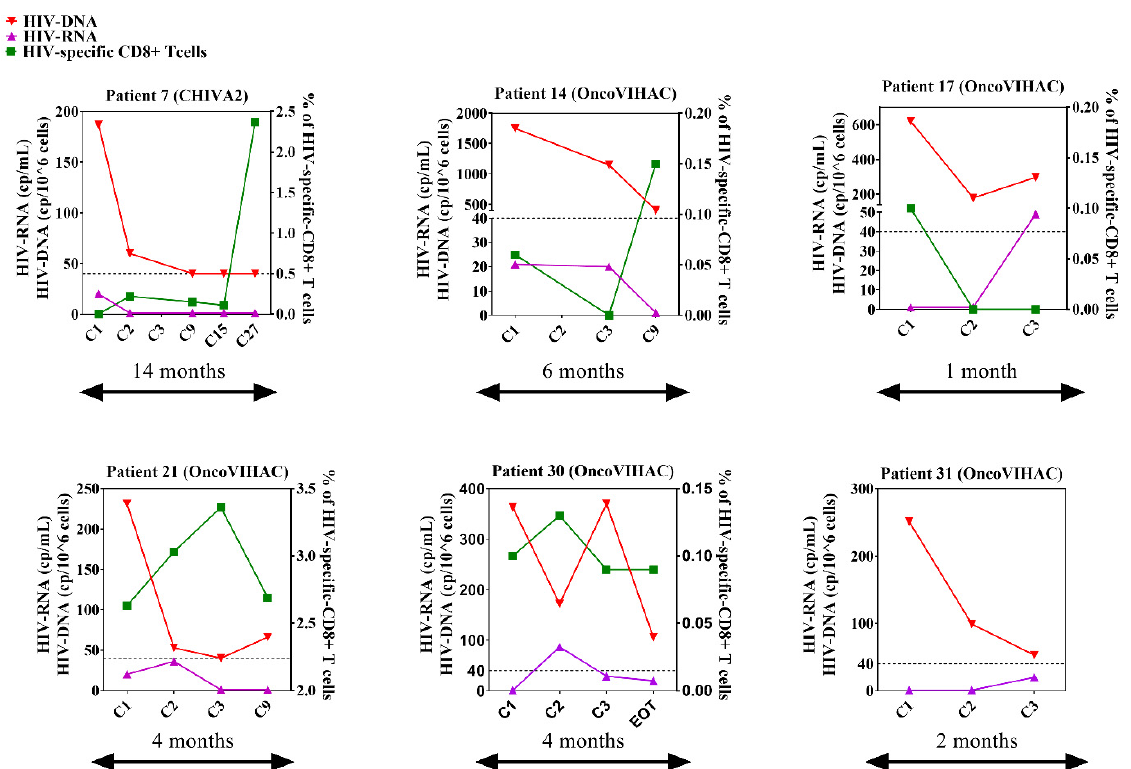
Figure 7. Immunovirological- profiles of the six PLWH patients treated with anti-PD-1 with a CA HIV-DNA decrease ≥ 0.5 log 10 . In each graph, red inverted triangles represent HIV-DNA (cp/10 ^6 cells), purple triangles represent HIV-RNA (cp/mL) and green squares represent HIV-specific CD8 + cells (% of total CD8 + T cells). Dotted lines represent CA HIV-DNA = 40 cp/10^ 6 cells, which is the detection threshold. EOT: end of treatment. The frequency of HIV-specific CD8 + T cells was not available for patient #31. Experiments were monoplicates.